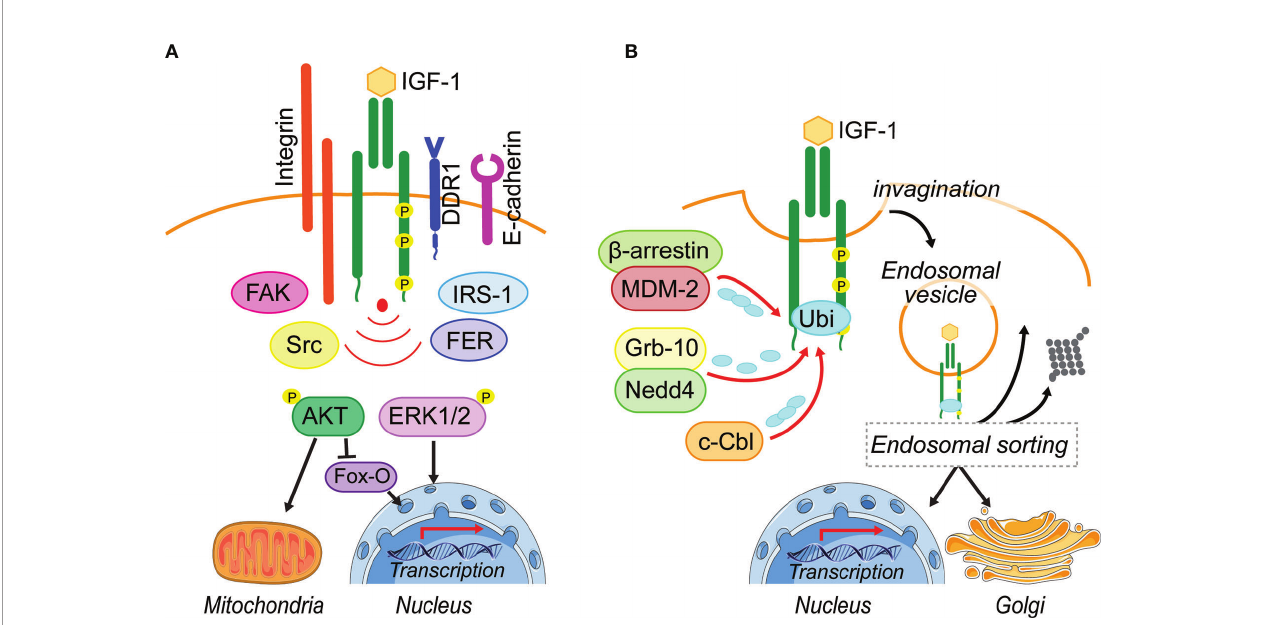
FIGURE 1 | Leaving the plasma membrane. (A) Located on the plasma membrane, activated IGF-1R induces two major pathways, PI3-K/AKT and MAPK/ERK1/2, to regulate cellular processes including metabolism and transcription. Different adhesion related kinases (FAK, Src, FER) and interacting proteins (IRS-1, DDR1) regulate IGF-1R endocytosis and thereby prolong or reduce IGF-1R signaling from the cell surface. In addition, these IGF-1R interacting proteins can enhance bias IGF-1R signaling or their cooperation is needed for the activation of IGF-1-induced pathways (Integrin). (B) Ligand-induced IGF-1R activation leads to the recruitment of E3-liages (MDM-2, Nedd4, c-Cbl) that can initiate IGF-1R poly- and mono-ubiquitination. Via membrane invagination and formation of clathrin- and caveolin- coated pits, the IGF-1R enters the cell in endosomal vesicles. It is assumed that the endosomal sorting system decides, whether IGF-1R gets degraded, travels back to the plasma membrane or translocates to intracellular membrane compartments. To this day it is unknown how the post-endocytotic IGF-1R translocation to intracellular membrane compartments, such as the Golgi and the nucleus is regulated and whether IGF-1R regulation of mitochondrial function is exclusively due to signaling transduction. Figure elements adapted from Servier Medical Art (https://smart.servier.com/), under license CC-BY3.0.